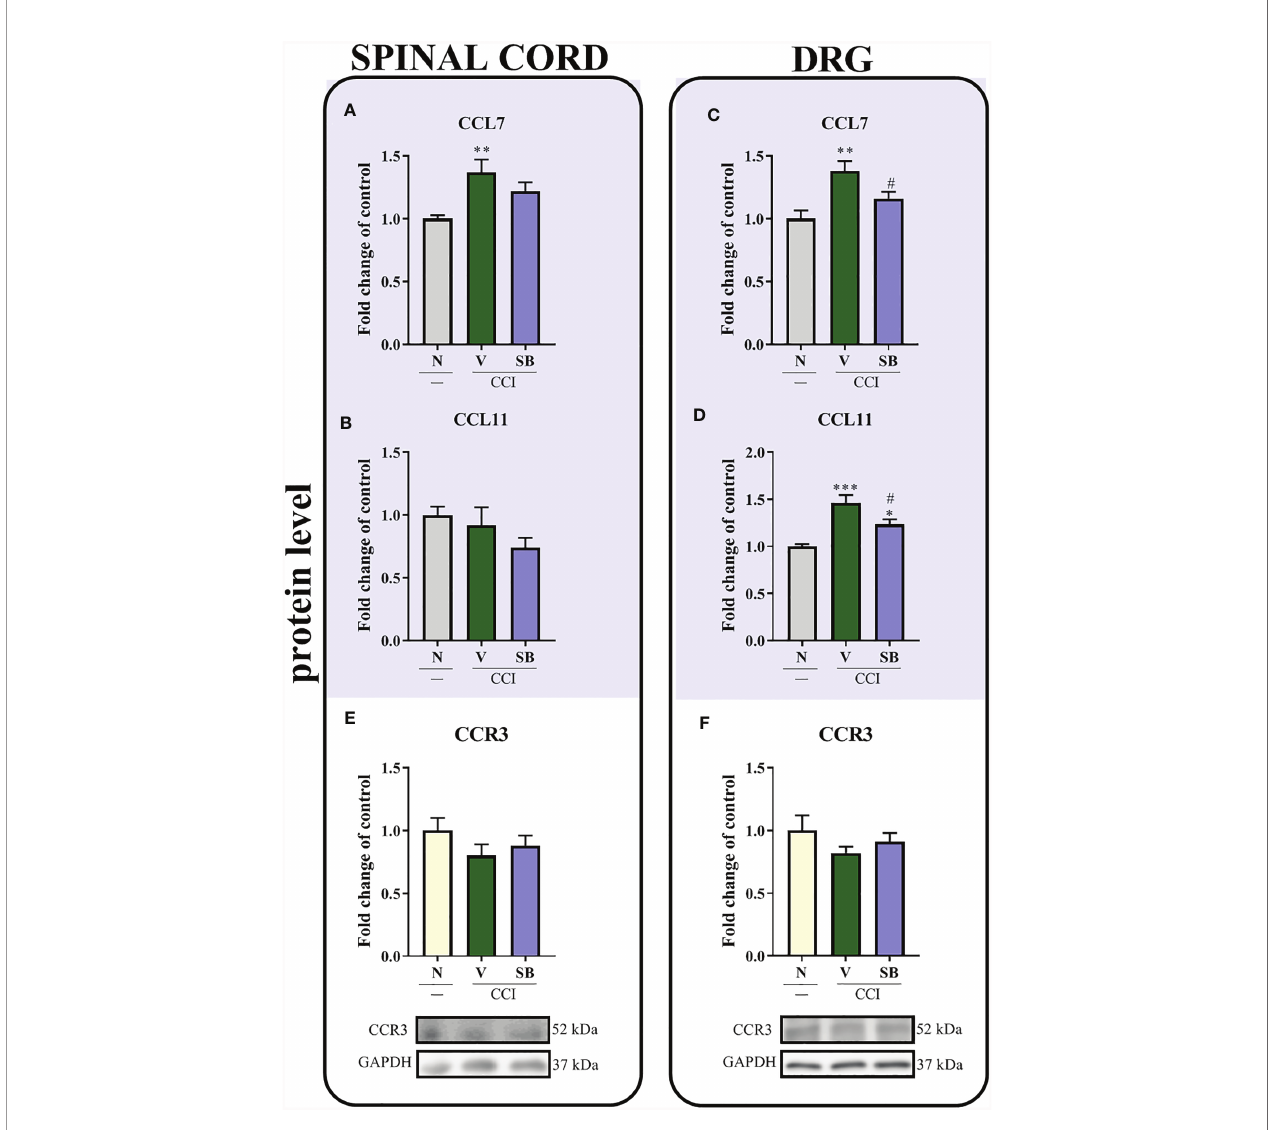
FIGURE 7 | Effects of repeated administration of SB328437 (SB, 10 m g/5 m l; i.t .); 16 h and 1 h before chronic constriction injury of the sciatic nerve (CCI) and then once a day for 7 days on levels of the CCL7 (A, C) , CCL11 (B, D) and CCR3 (E, F) proteins in the rat spinal cord (A, B, E) and the DRG (C, D, F) on the 7 th day post-CCI, as measured using ELISA (A – D) and Western blotting (E, F) . The data are presented as the mean fold changes relative to the control ± SEM (5 – 8 samples per group). Intergroup differences were analyzed using ANOVA with Bonferroni ’ s post hoc test for multiple comparisons. *P < 0.05, **P < 0.01 and ***P < 0.001 indicate a signi fi cant difference compared with the control group (naive, N rats); # P < 0.05 indicates a signi fi cant difference compared with the Vehicle (V)-treated